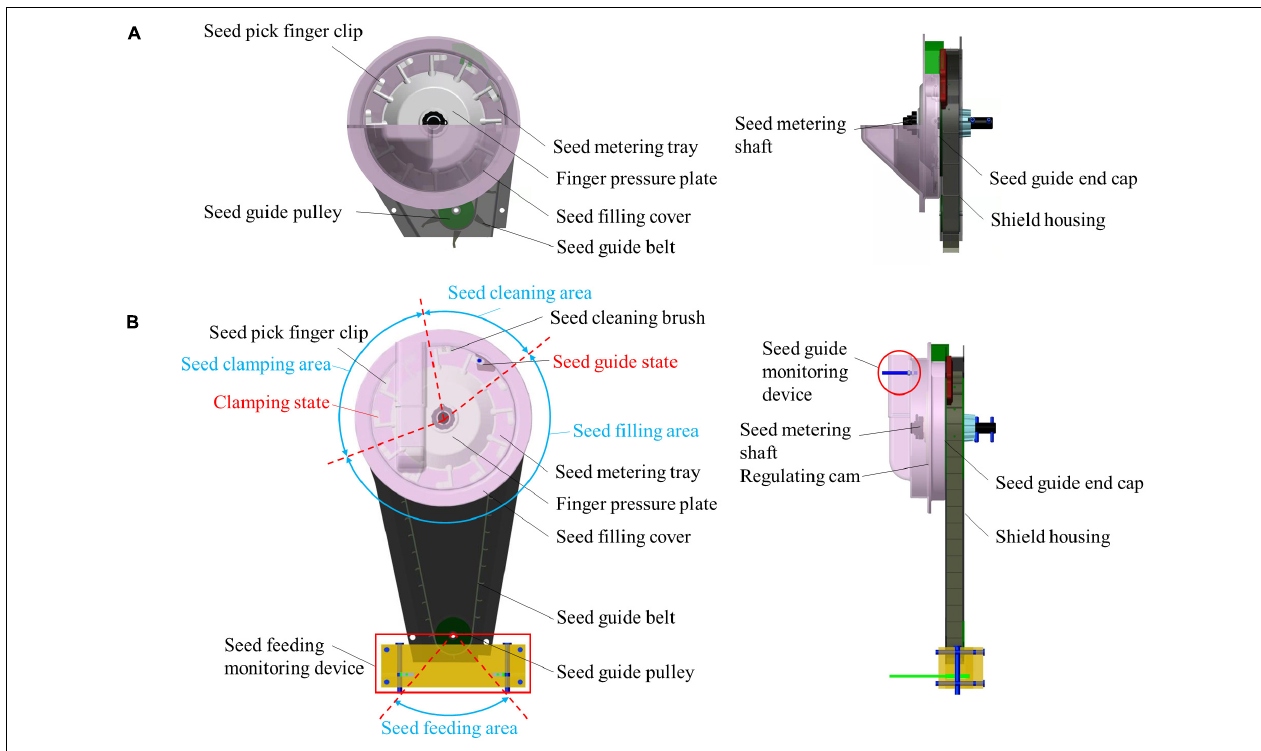
FIGURE 1 | Overall structure. (A) Overall structure of conventional finger-clip precision corn seed metering device. (B) Overall structure of long-belt finger-clip precision corn seed metering